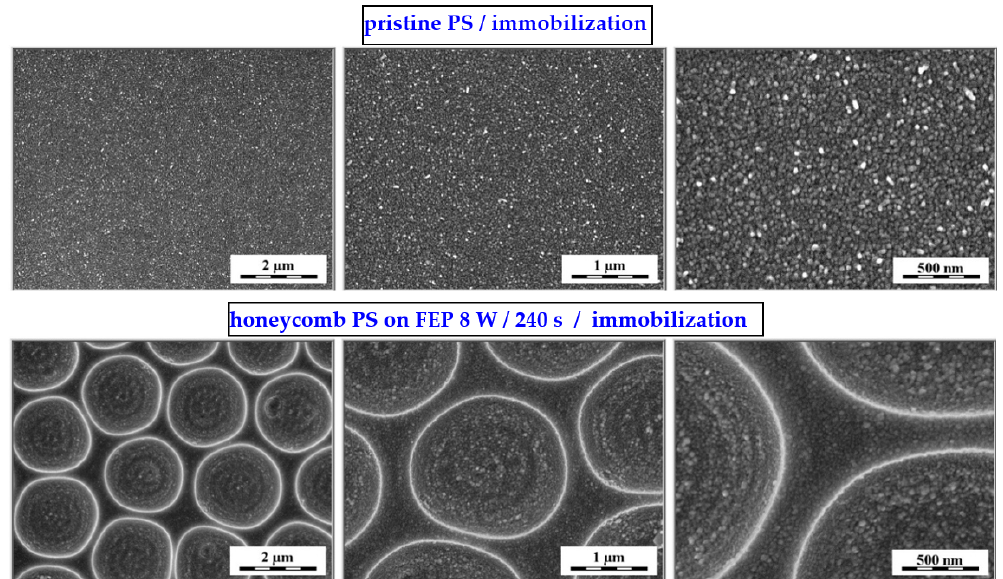
Figure 6. SEM scans of three different scanning areas of polystyrene honeycomb patterns immobilized with Ag nanoparticles from the solution (bottom line) and pristine polystyrene foil, which was exposed to the same conditions.